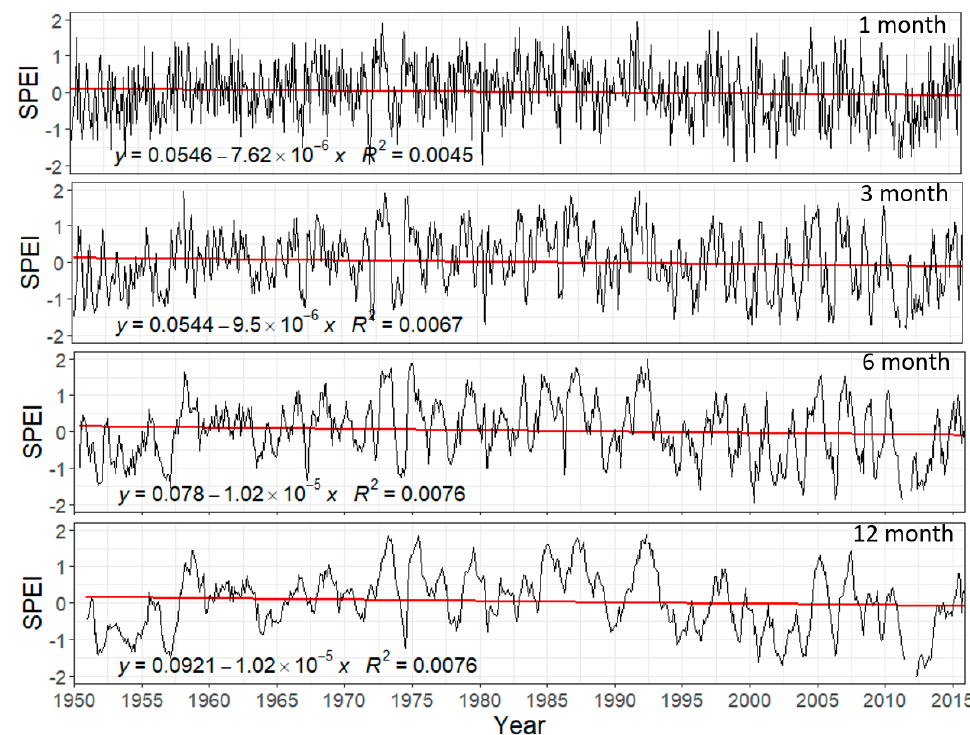
Figure A4. Time series of the spatial mean of 1-, 3-, 6-, and 12-month SPEI timescales for a period of 1950 January to 2015 December significant at p ≤ 0.05 of the Chihuahuan Desert [31].